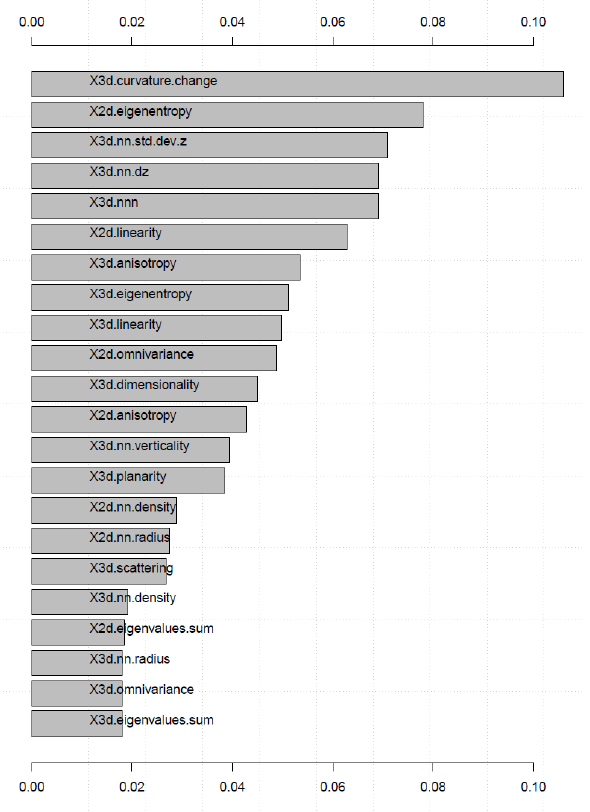
Figure 6. Variable importance for RF.